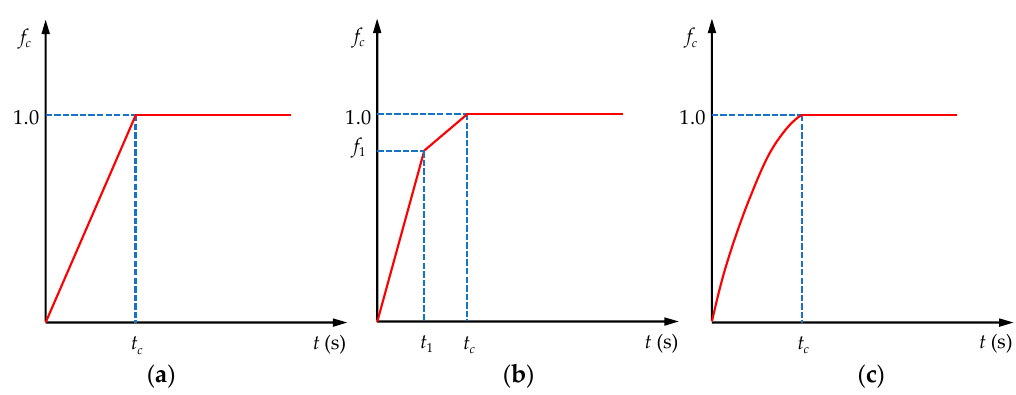
Figure 4. Desired rise curves of rotating speed for the closed-loop control strategy (CLCS): ( a ) Linear opening scheme; ( b ) two-phase opening scheme; and ( c ) exponential opening scheme, where t c is the time rising from 0 to rated speed at the desired speed and t 1 and f 1 are the switching time and frequency of the turning point of the two straight lines,